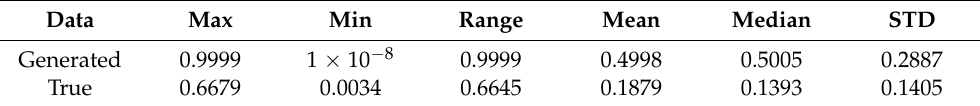
Algorithm 1 is used in several rounds of testing. The k corresponding to each ε